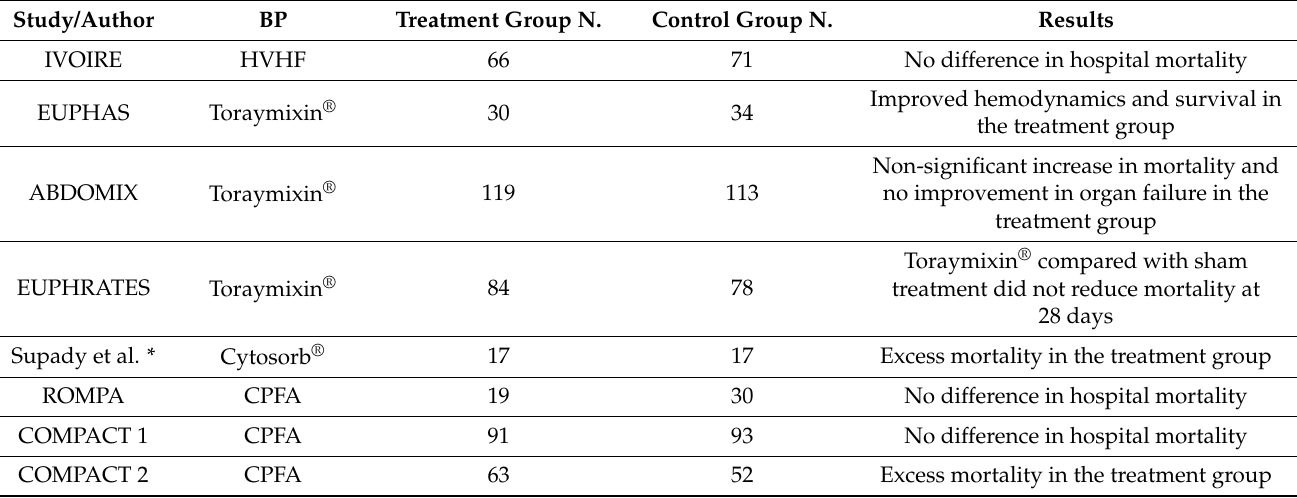
Table 2. Results of some RCTs of BP in septic shock